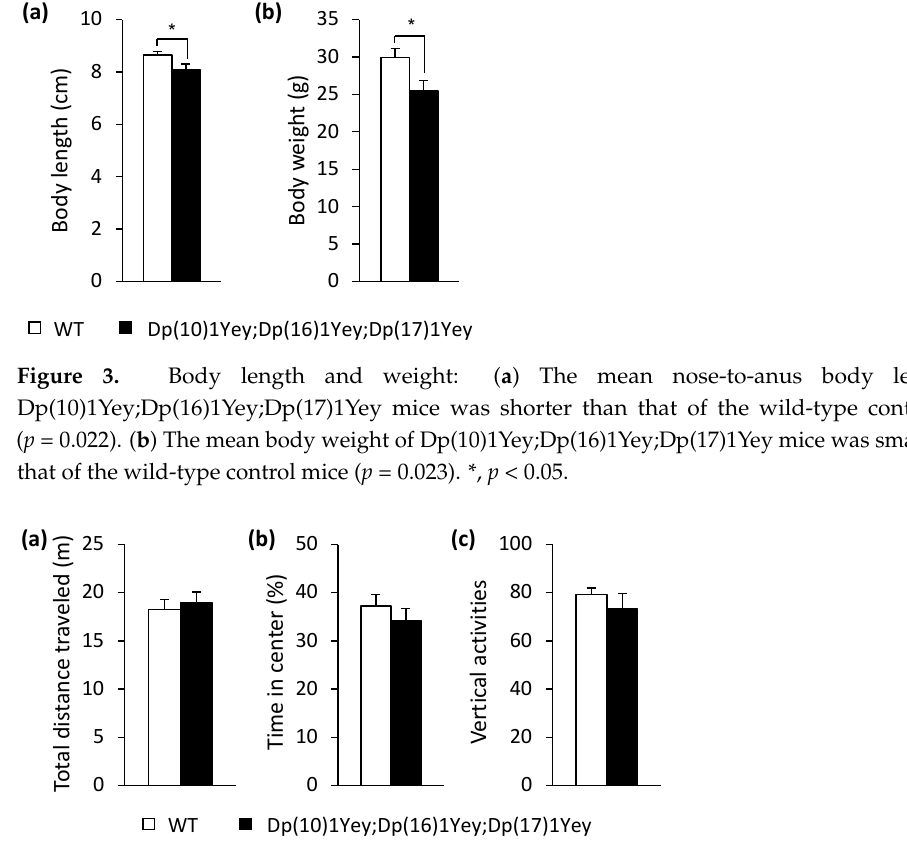
Dp(10)1Yey;Dp(16)1Yey;Dp(17)1Yey mice was significantly lower than that of the wild- pocampal function (Figure 5).